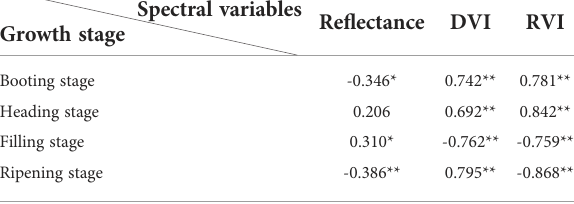
TABLE 5 Correlation coef fi cients ( r ) of the most sensitive re fl ectance and vegetation indices to amylose content. Spectral variables Re fl ectance